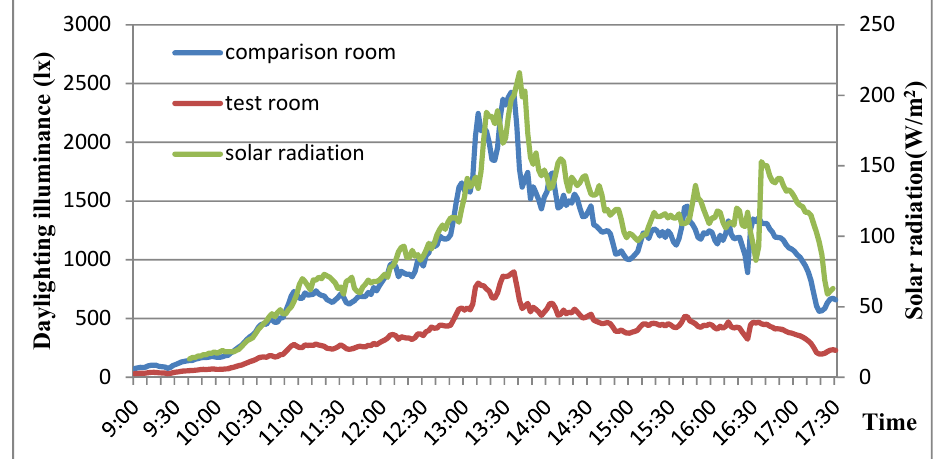
Figure 12. Illumination on work surface in 13 February 2018.